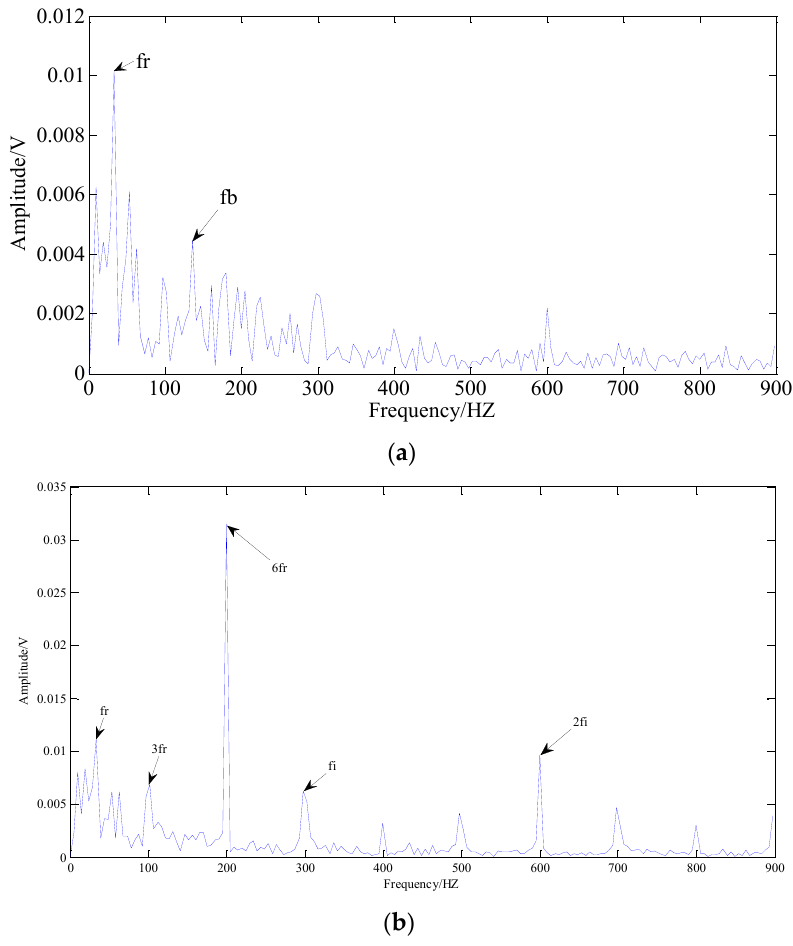
Figure 16. The results derived by the proposed method: ( a ) the first result in frequency-domain derived by the proposed method; and ( b ) the second result in frequency-domain derived by the